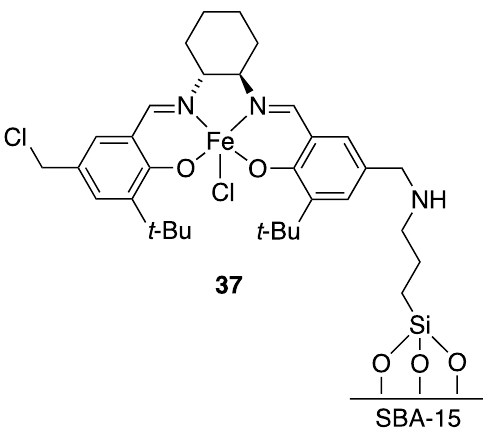
Figure 15. A Fe–salen complex immobilized on mesoporous silica